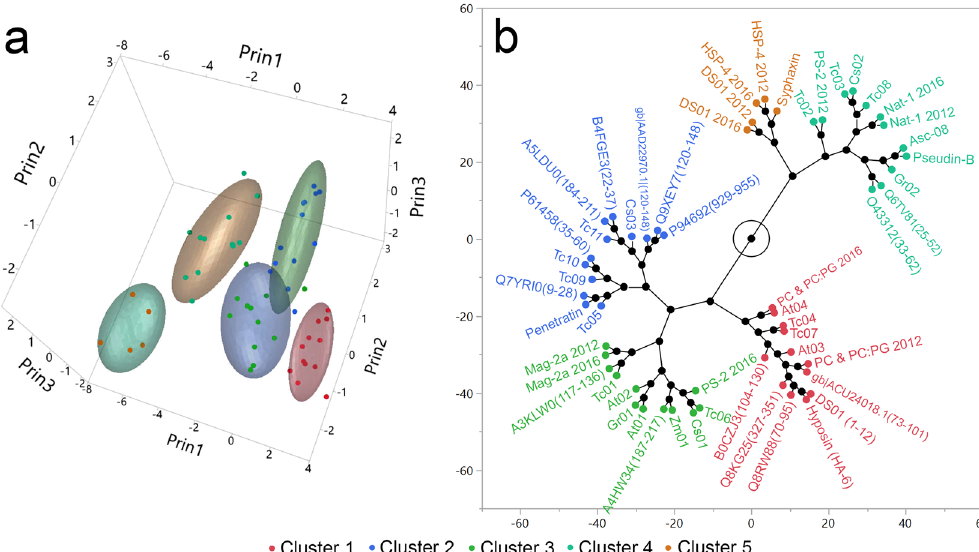
Figure 4. Meta-analysis of peptide-induced effects on thermograms can be used as an incremental framework for the classification of novel membrane-active peptides. Previously-acquired peptide-model membrane thermograms data 4 were incorporated into the model (Table 1, 2012 and 2016 set). Peptides from the 2012 and 2016 data sets were standardized separately and submitted to a new principal component analysis (Supplementary material 02) and the first five principal components were recorded (~85% of the data variance). A hierarchical clustering analysis (HCA) algorithm was applied to peptide locations on the first five principal components. ( a ) 3-D scatterplot of the peptide positions on the first three principal components. Peptide clusters, obtained from HCA, are color coded: Cluster 1, in red, cluster 2 in blue, cluster 3 in green, cluster 4 in light green and cluster 5 in gold. Normal contour ellipsoids (coverage 0.66) were calculated for peptide clusters. ( b ) Constellation plot of the dendrogram obtained from HCA categorizes peptides in discrete clusters. Cluster identities are also represented using a color